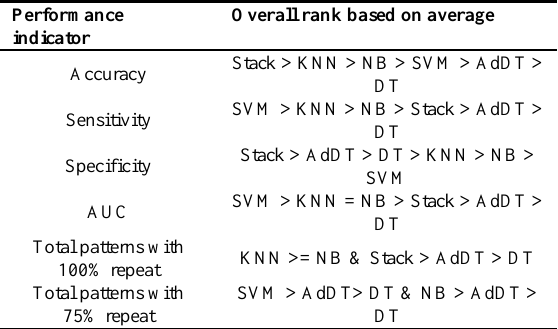
Table 4. Overall rank of six technique ranks based on average performance (fist four columns) and repeated patterns extracted from first column (two last columns).